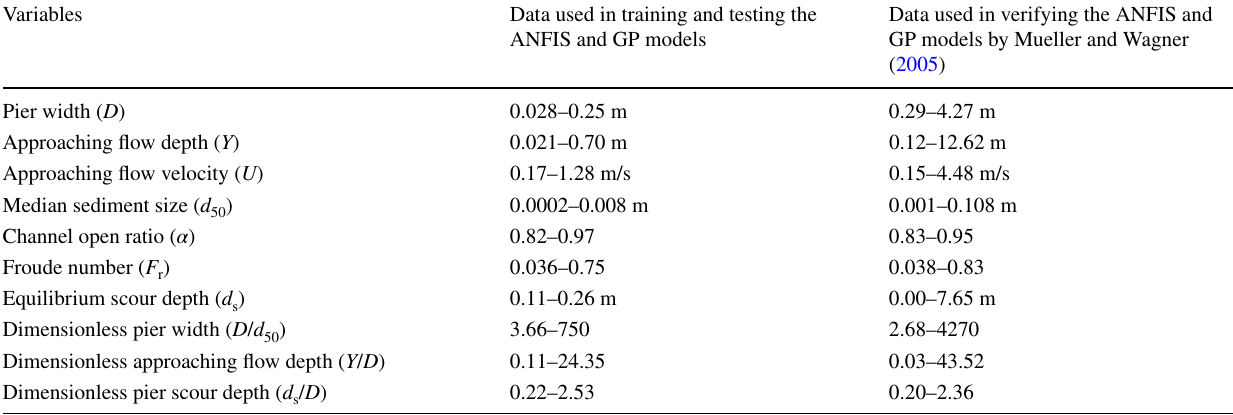
Table 1 Ranges of data used in the development of ANFIS and GP models Variables Data used in training and testing the